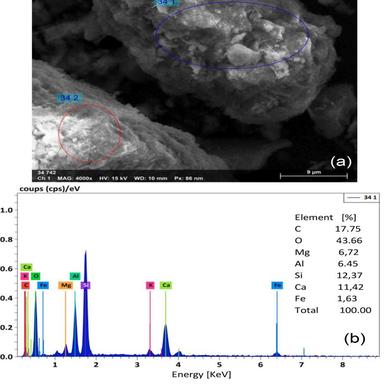
SEM-EDS results of the clayey sample: (a) SEM image (b) EDS.